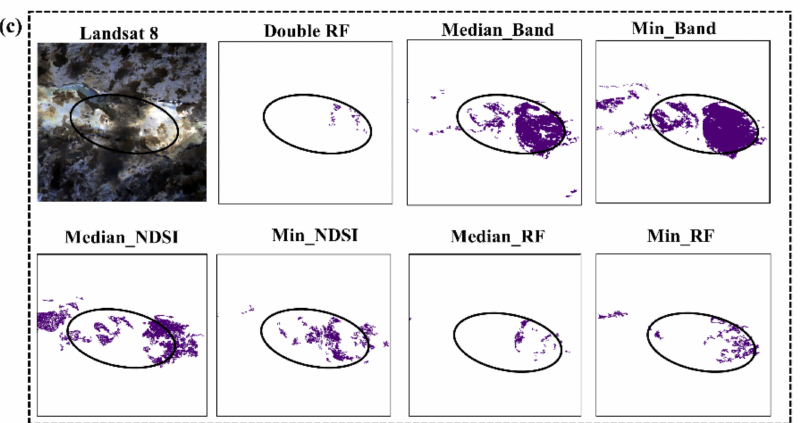
Figure 15. Extraction results of glaciers in shadow ( a ), debris-covered glaciers ( b ), and glacial lakes ( c ) using seven methods. The red line is the glacier reference boundary of glacier dataset. The parts circled in black or yellow lines are glaciers in shadow, debris-covered glaciers, and glacial